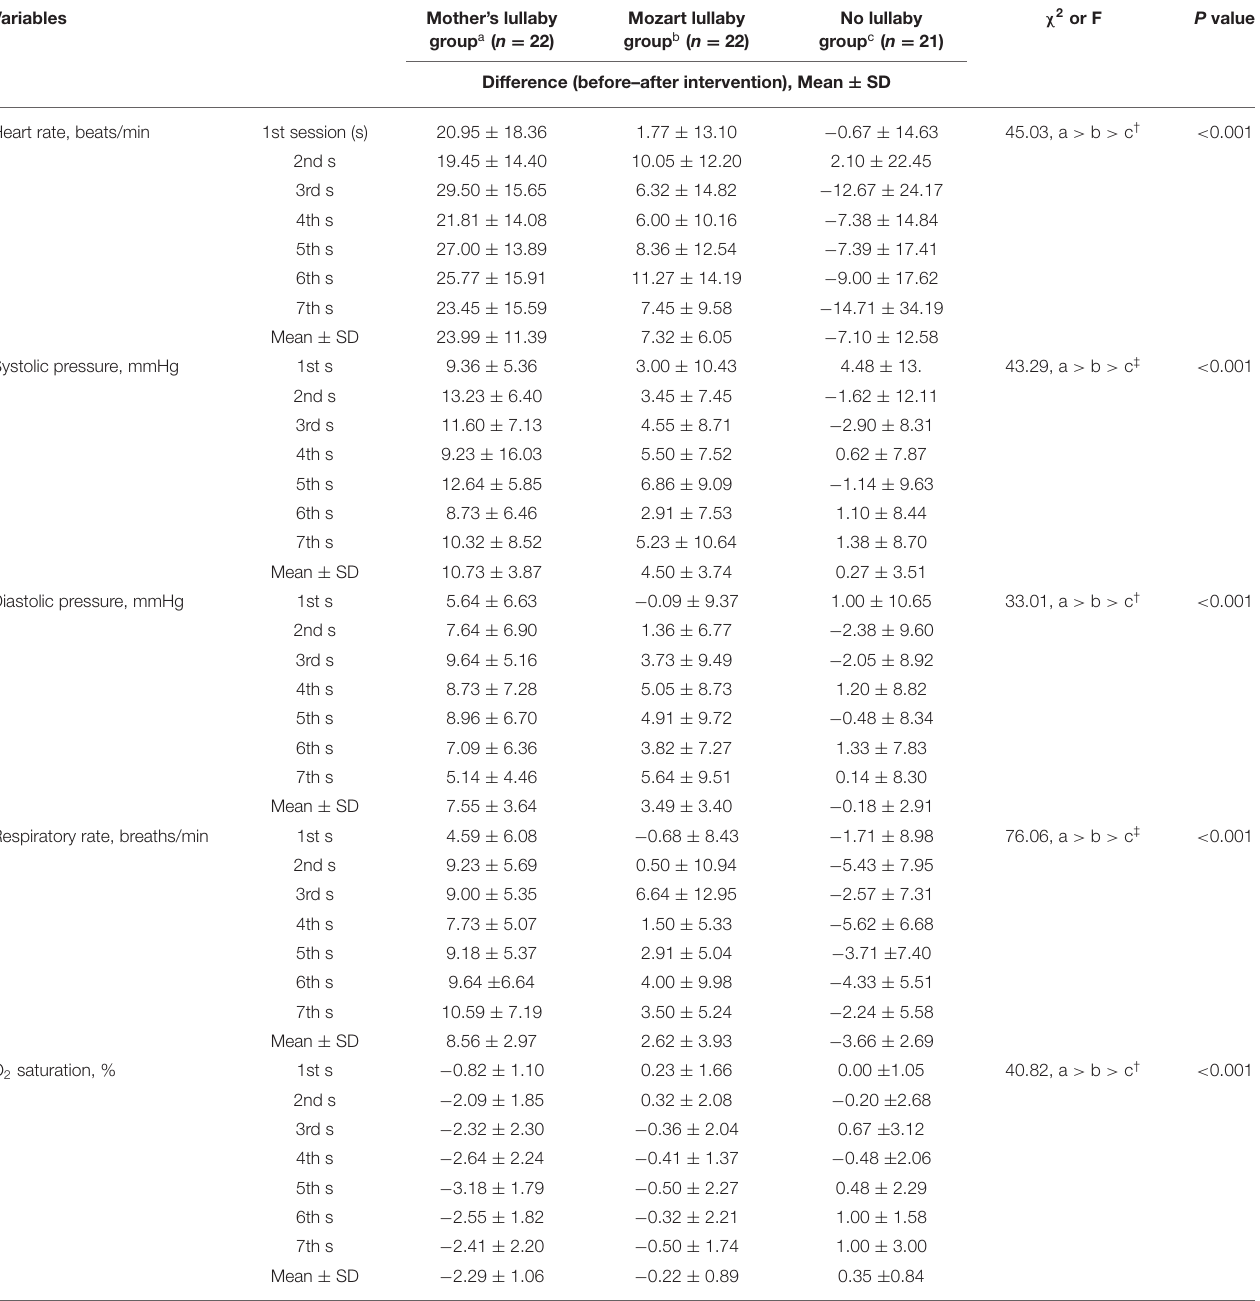
TABLE 2 | Comparison of heart rate, O 2 saturation, blood pressure, and respiratory rate between groups ( N = 65).